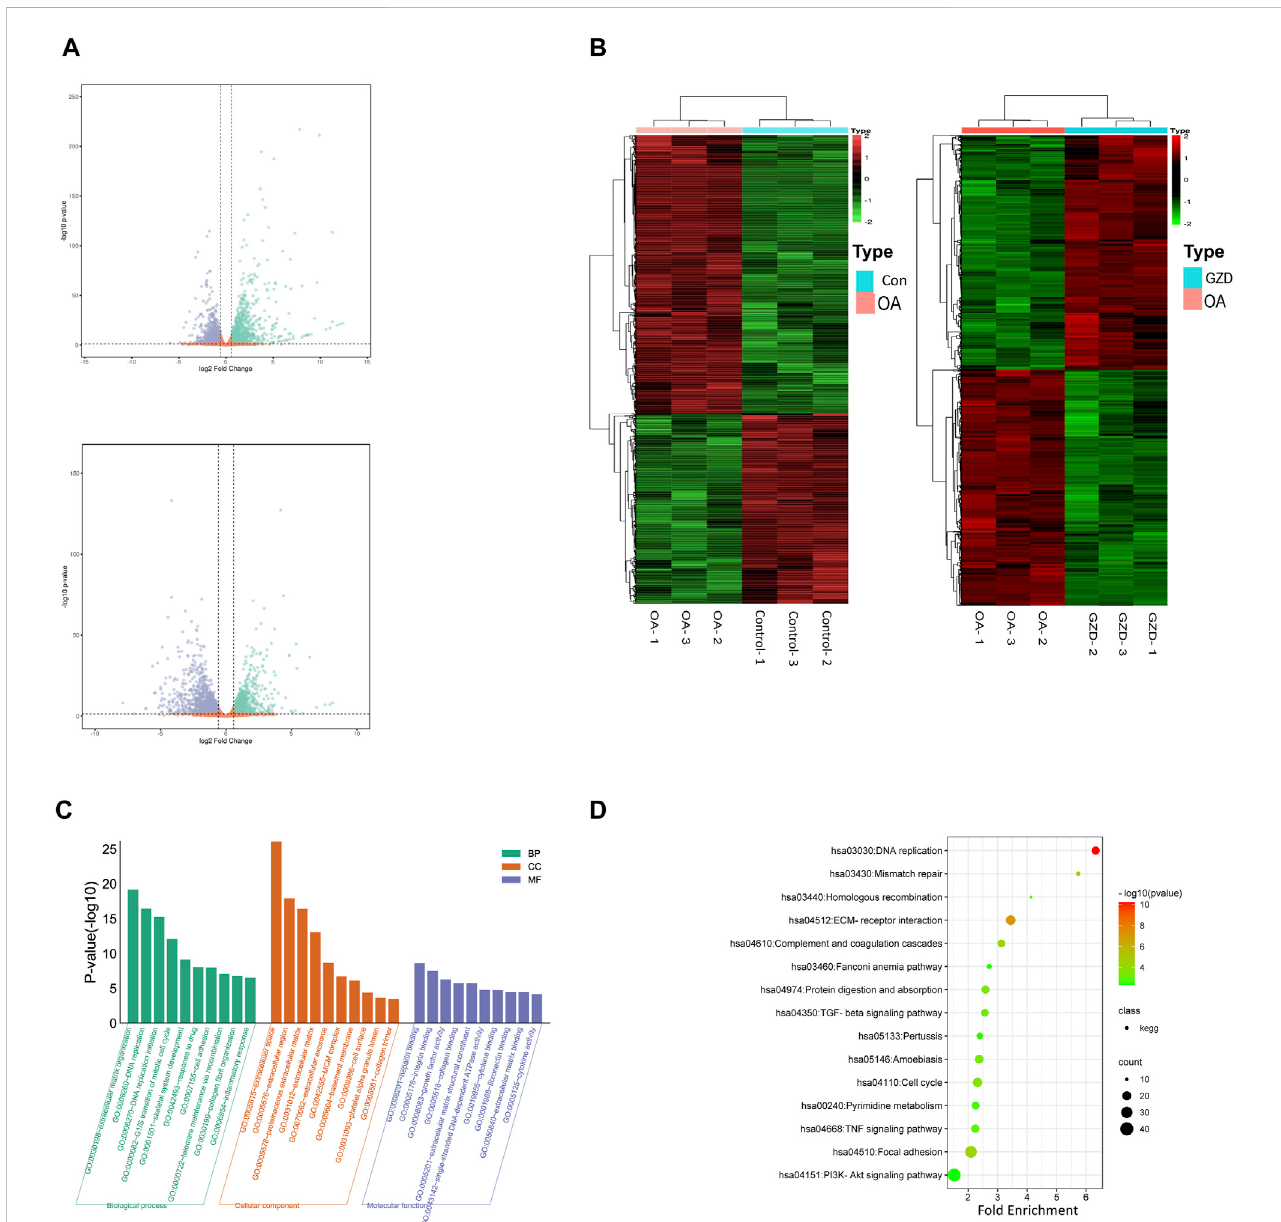
expressedgenesde fi ningtheOA andControl (left)groups ortheOA andGZD (right) groups,and red dotsshow that genes levels are upregulated. Green dots are downregulated. (C) Gene Ontology terms of candidate targets of GZD against OA. Top 30 GO functional categories with p -adjusted value < 0.05 are selected. (D) KEGG pathway enrichment of candidate targets of GZD against OA. Pathways that had signi fi cant changes of p < 0.05 are identi fi